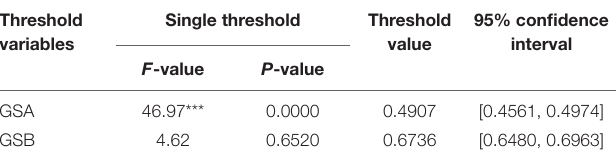
TABLE 10 | Results of the threshold effect